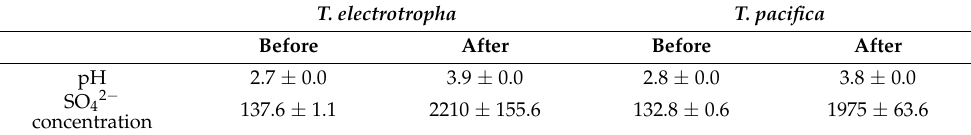
Table A8. pH and sulphate (SO 42 − ) concentration before and after bioleaching of the Neves Corvo waste rock (NC_01) by the spent mediums of T. electrotropha and T. pacifica at high temperature and pressure.